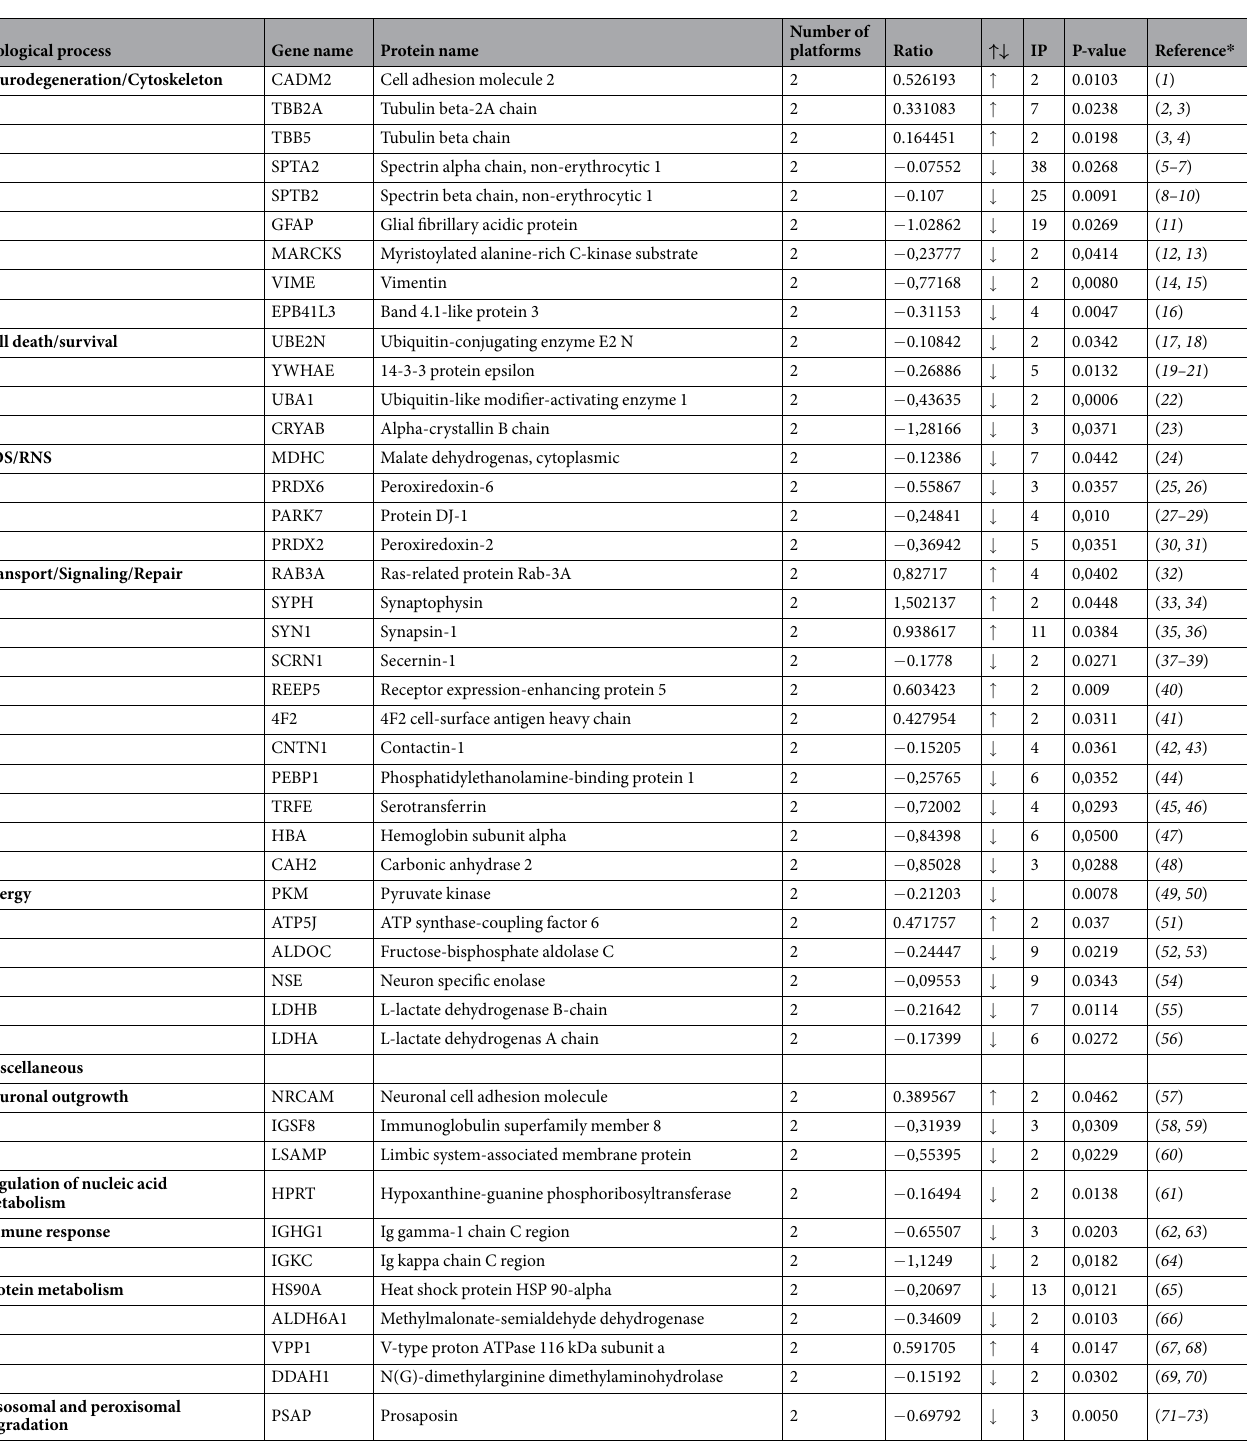
Table 3. Mass spectrometry analysis of brain tissue biopsies from structurally normal-appearing frontal cortex- STUDY A . Significantly up- or downregulated proteins in a cohort of severe traumatic brain injury (TBI) patients in comparison to patients with idiopathic normal pressure hydrocephalus (iNPH). IP = Number of identified peptides, ↑↓ = Increased or decreased, * = Reference provided in supplementary